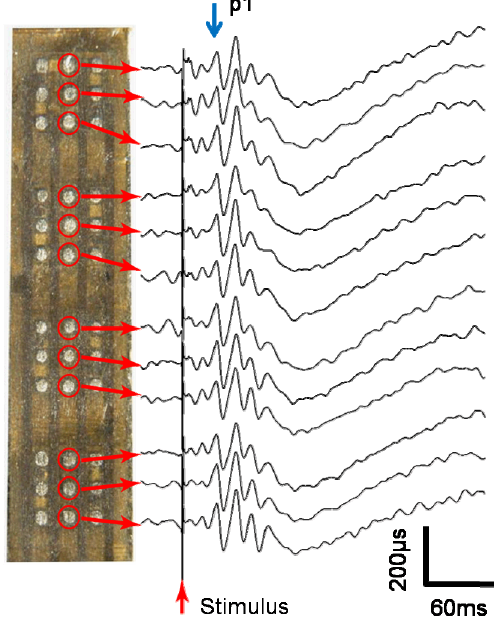
Figure 13. EEP signals obtained in an in vivo experiment using the implanted retinal